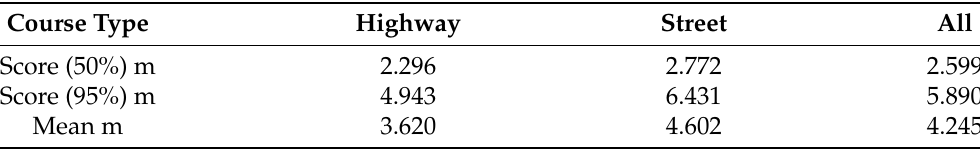
Table 1. Score of baseline position for each course type in training dataset of GSDC